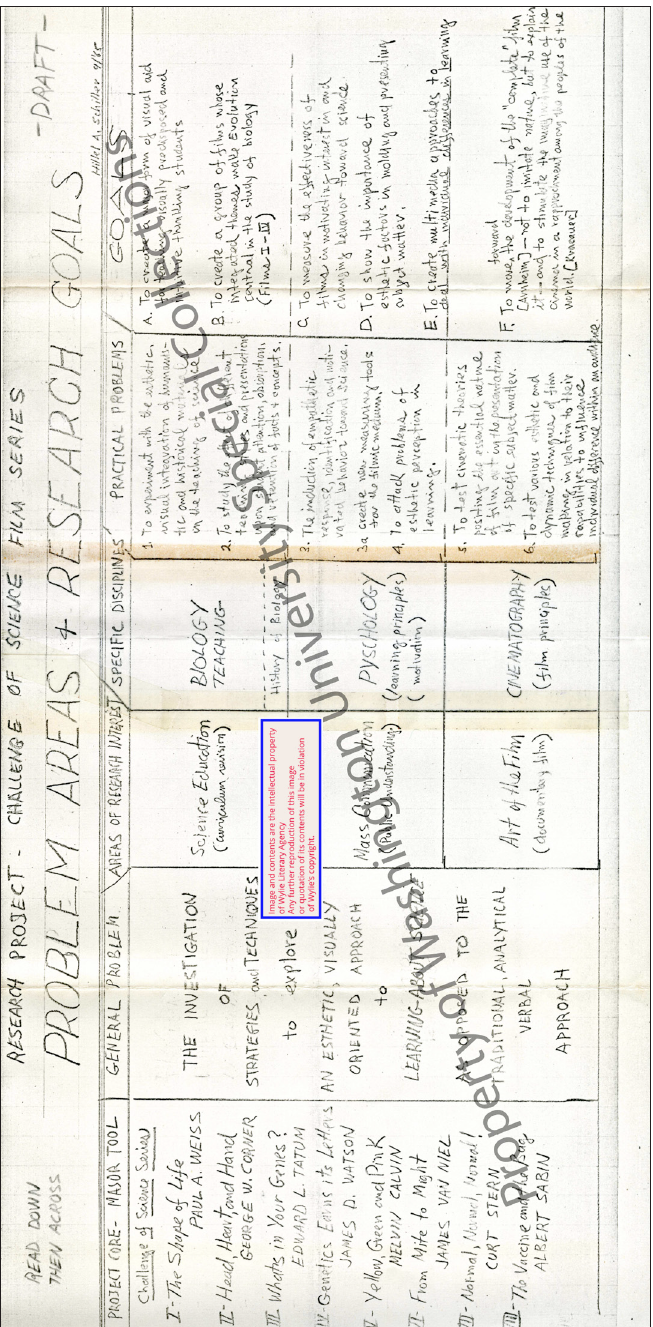
Figure 6: ‘Problem Areas and Research Goals’ for the Challenge of Science